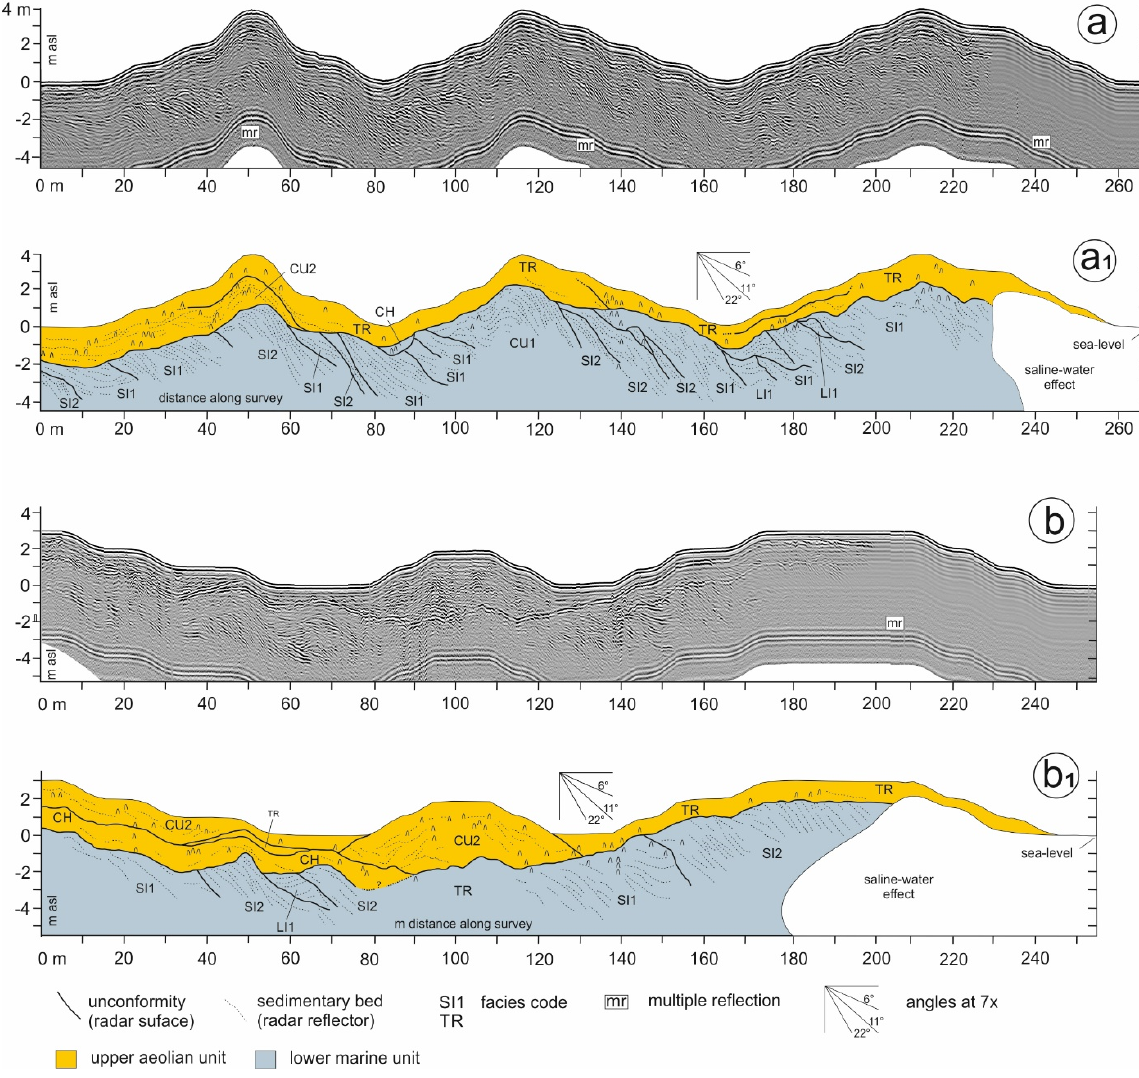
Figure 6. Processed ( a , b ) and corresponding interpreted ( a 1 , b 1 ) GPR profiles. For profiles location see Figure 2. Figure 6. Cont